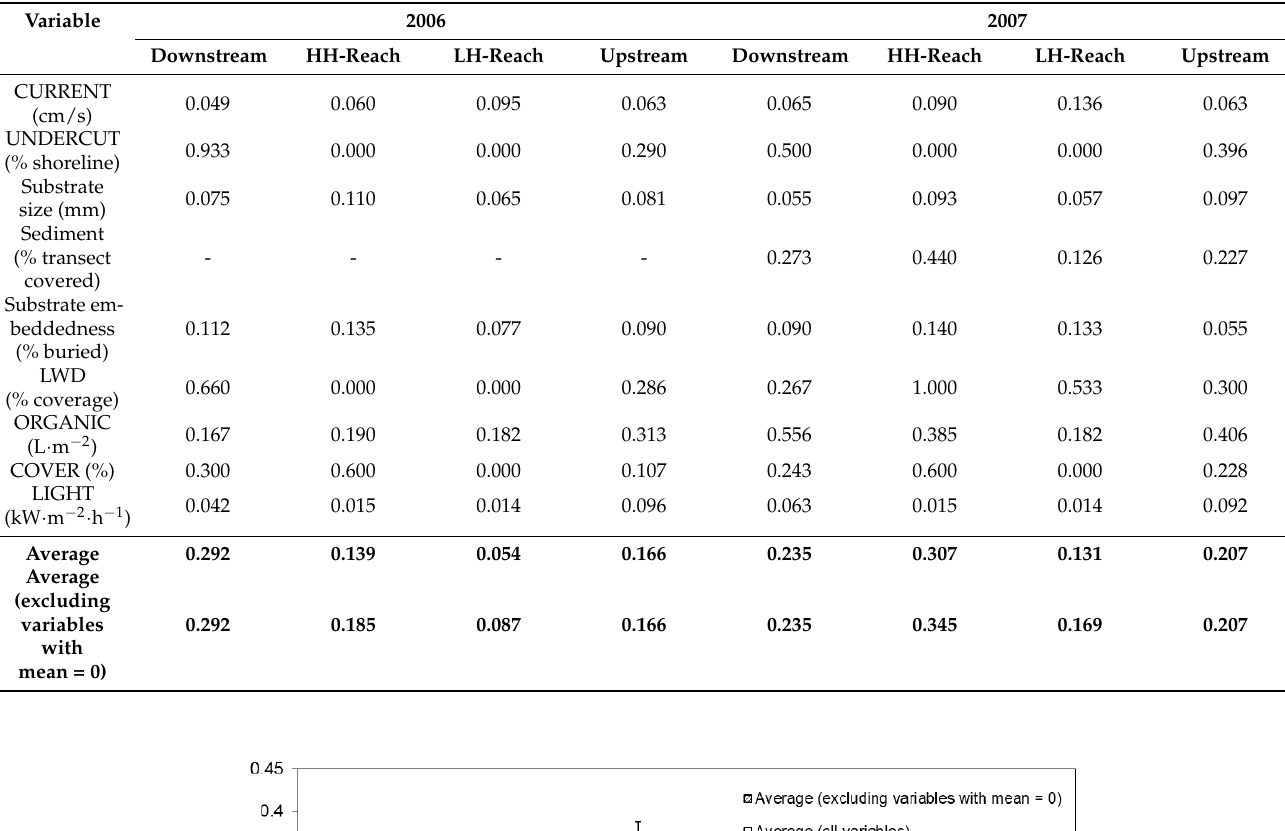
Table A1. Relative standard error (RSE = standard error/mean) values for each quantitative variable in each sampling reach and year. Higher values reflect greater variability, or heterogeneity, between the 10 transects sampled in each reach and year relative to the mean value. Average RSE values across all habitat variables are provided for each reach and year, as are similar values calculated excluding variables with mean = 0 in a given reach and year (e.g., UNDERCUT, LWD, and COVER in the HH- or LH-reach in 2006 or 2007). The latter calculation removes the effects of a given habitat element being absent from the stream reach. Sediment was not quantified in 2006 and thus, was not included in average calculations for that year.